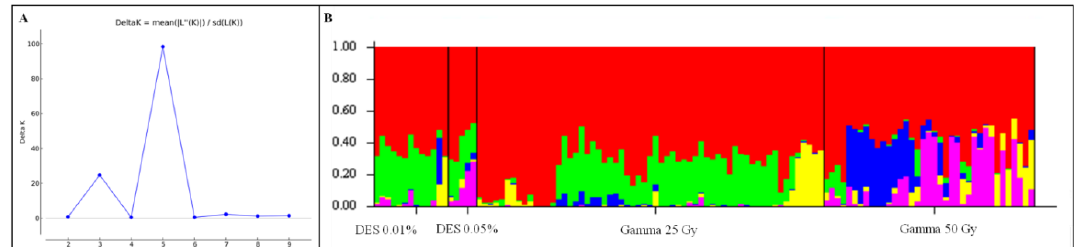
Figure 2. Population structure of the ILB4347 mutant populations. ( A ) Evanno’s ΔK value, with K = 1–10, showing peak at K = 5. ( B ) Genetic structure inferred by STRUCTURE program, with K = 5. Each sample is represented by a vertical bar segmented into K colored parts. The length of each colored part is proportional to the membership of coefficient (Q). The black vertical lines separate different mutant populations.